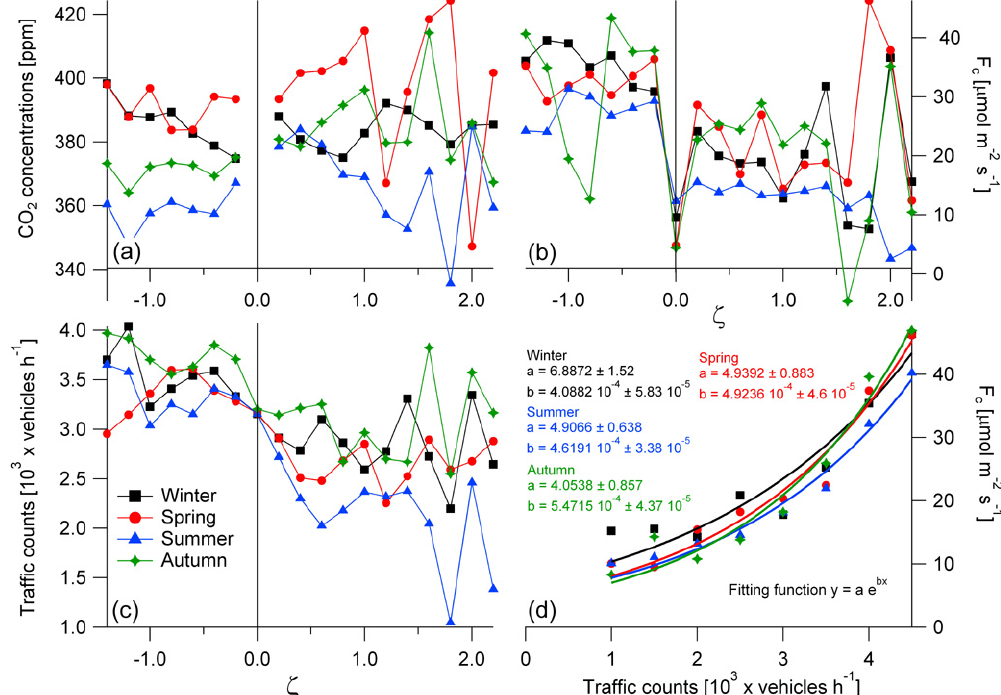
Fig. 6. (a) CO 2 concentrations, (b) CO 2 fluxes, (c) traffic counts as a function of atmospheric stability and (d) CO 2 fluxes as a function of traffic counts.